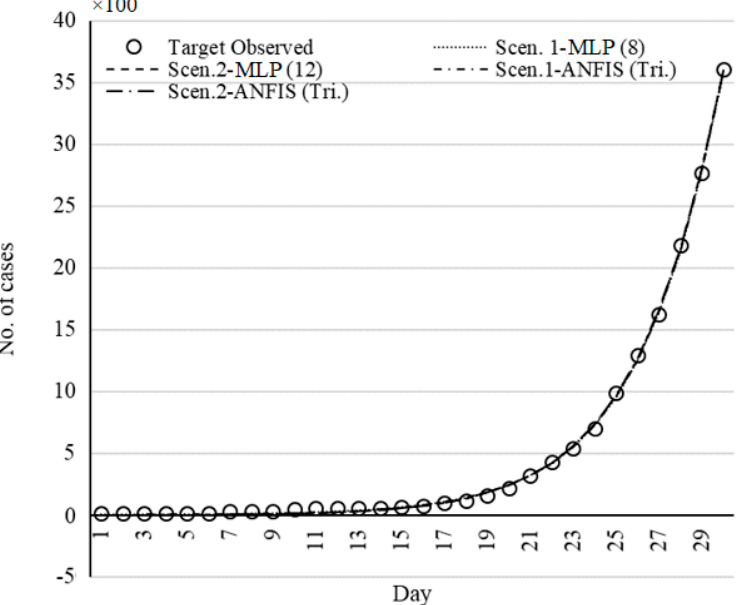
Figure 16. Set of models for USA fitted by ML methods.